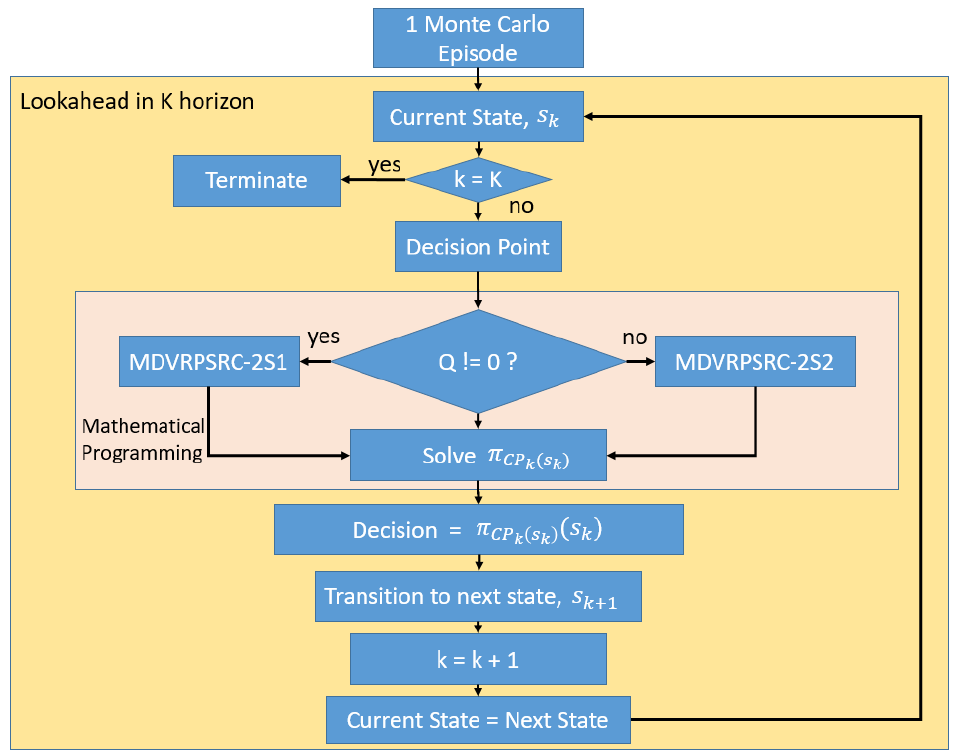
Figure 2. Proposed Matheuristic Rollout Concept for One Monte Carlo